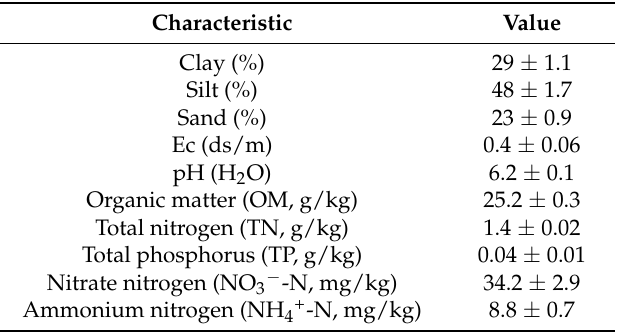
Table 1. Soil physical and chemical properties (mean ± standard